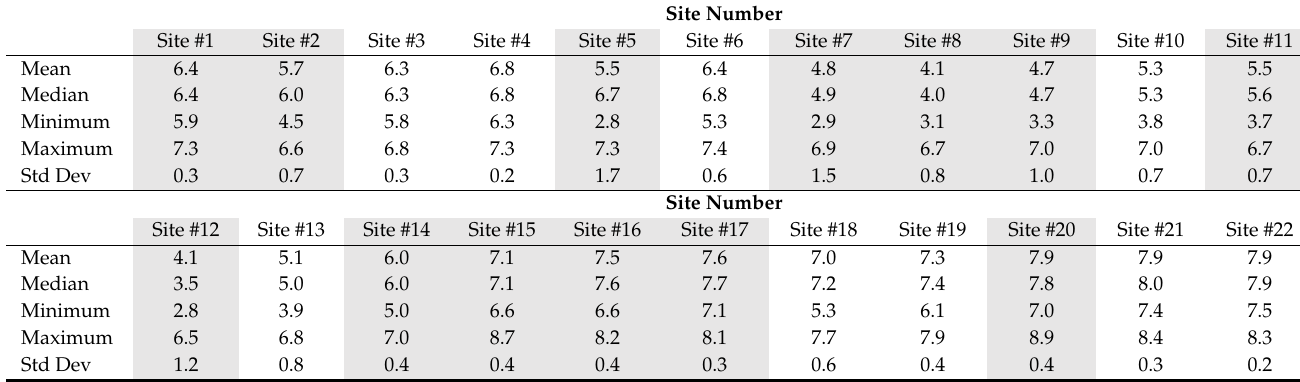
Table A2. Descriptive statistics of pH by sampling location ( n = 22) during the study period (3 March–3 November 2020) in West Run Watershed, WV, USA. Shaded cells identify tributaries to main stem West Run Creek (unshaded). pH values reflect weekly sampling during the study